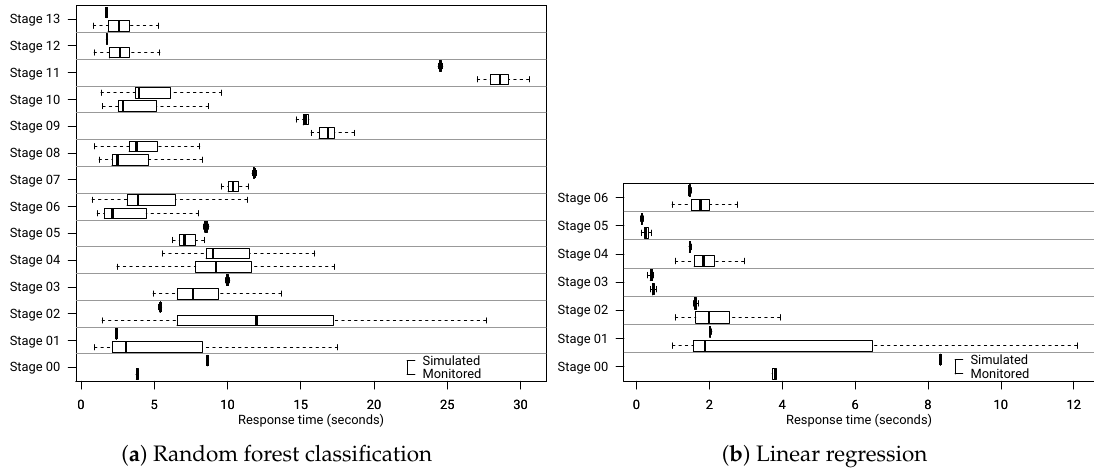
Figure 9. Response time statistics of Spark tasks for each stage (16 worker nodes, huge data